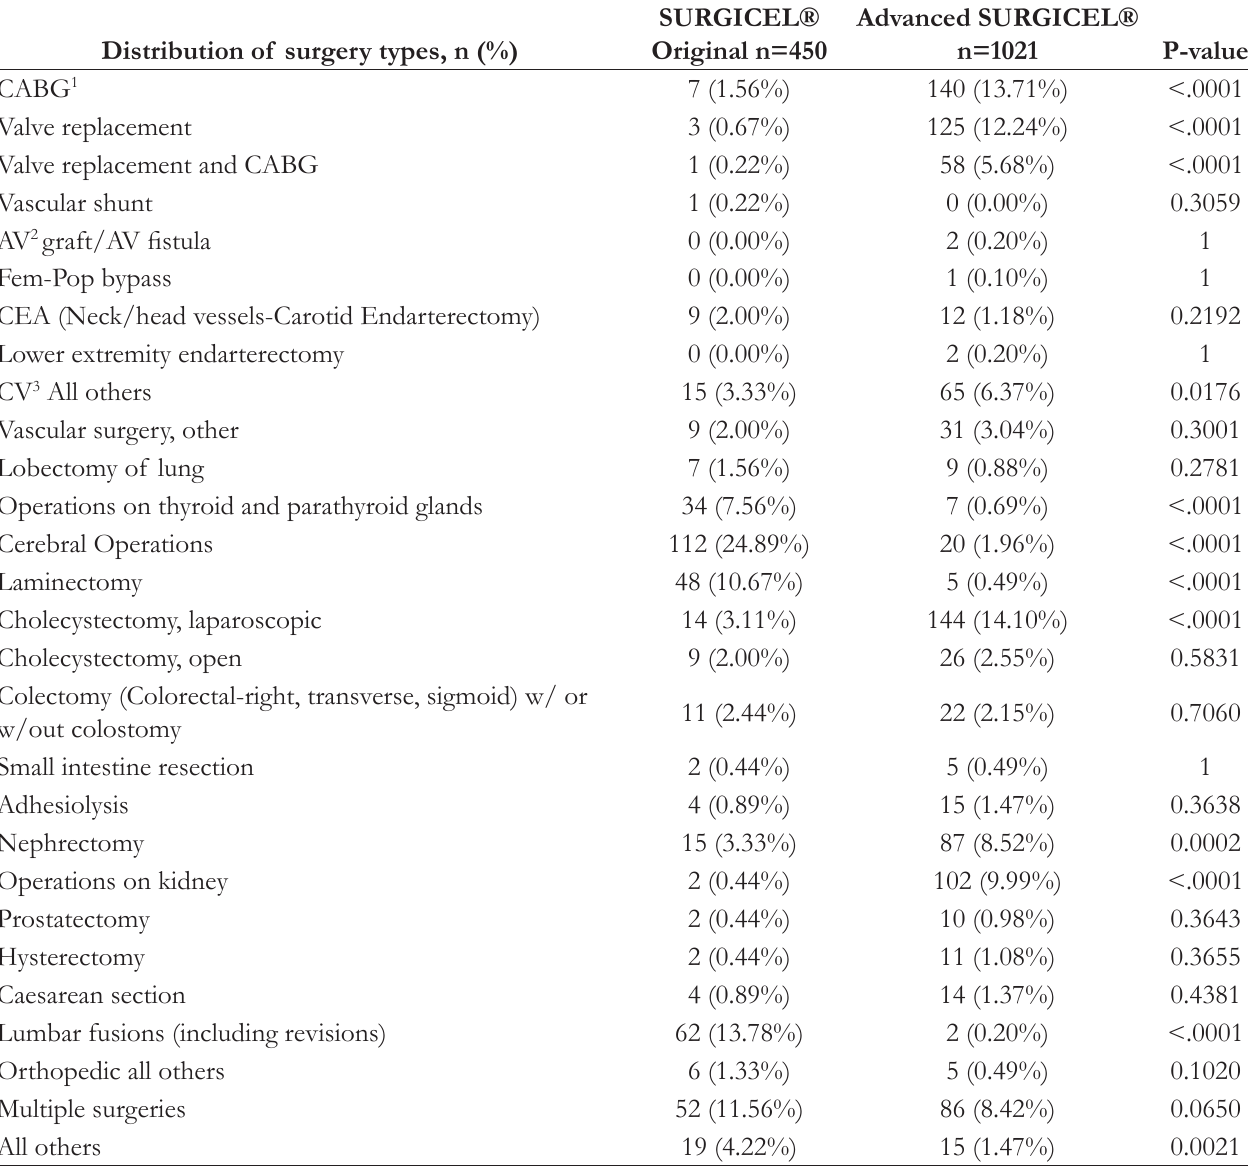
Table 2. Surgery type distribution, N=1471 Distribution of surgery types, n